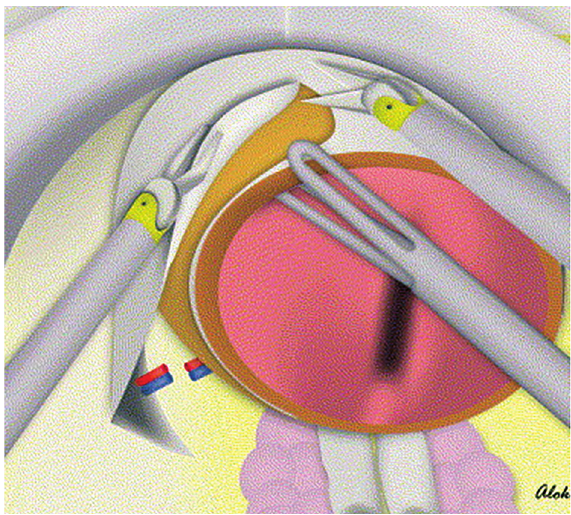
Figure 3 – Place of dissection for ‘veil of Aphrodite’ (from ref. 21, with permission from Elsevier